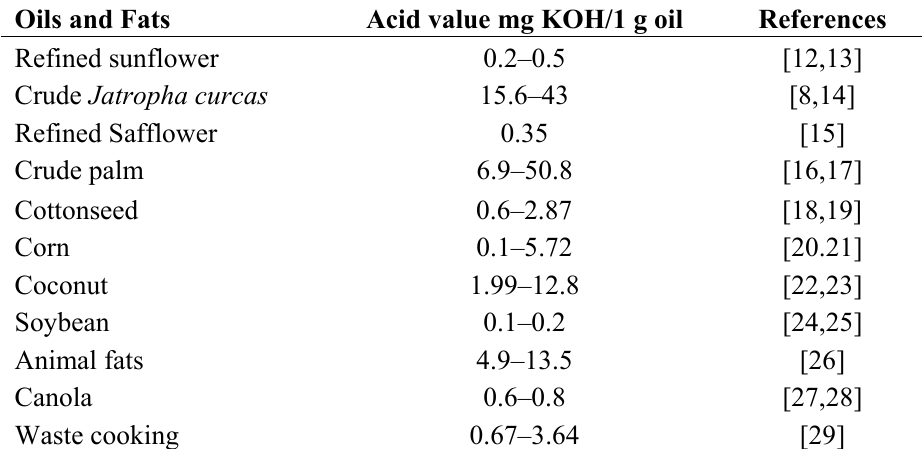
Table 4. Acid value in representative